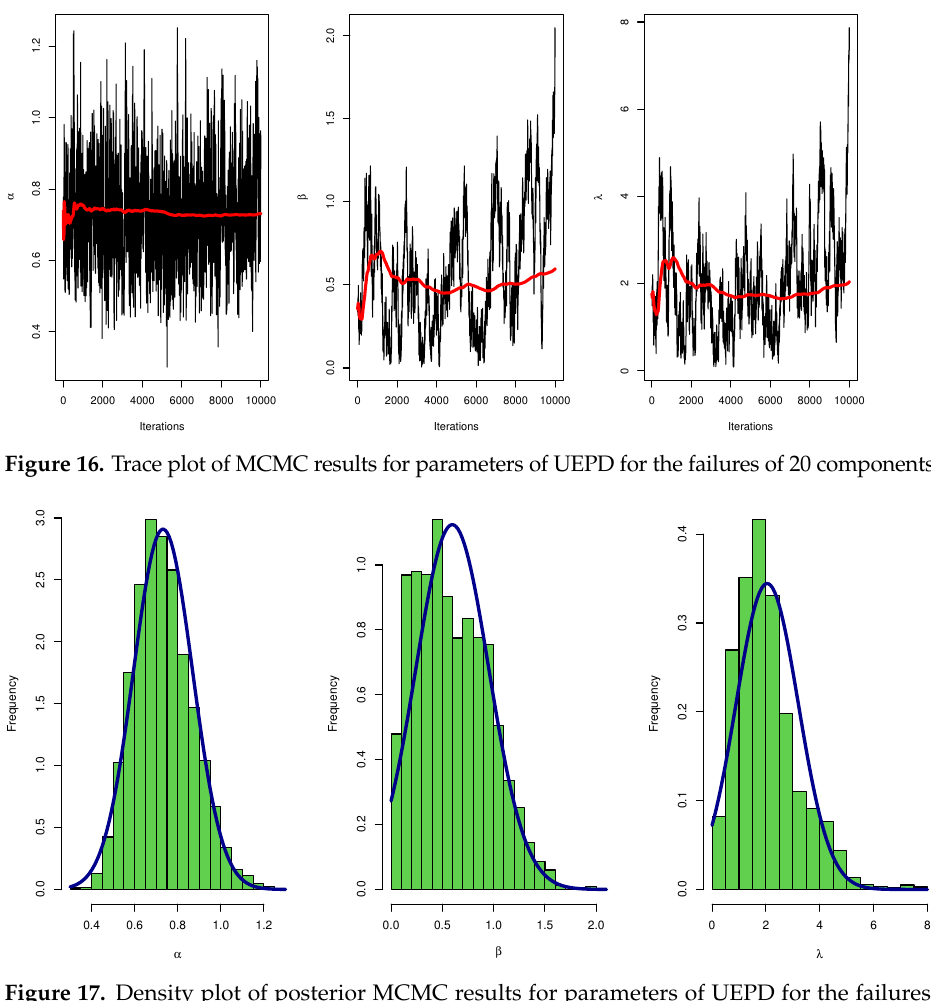
Figure 17. Density plot of posterior MCMC results for parameters of UEPD for the failures of 20 components data.